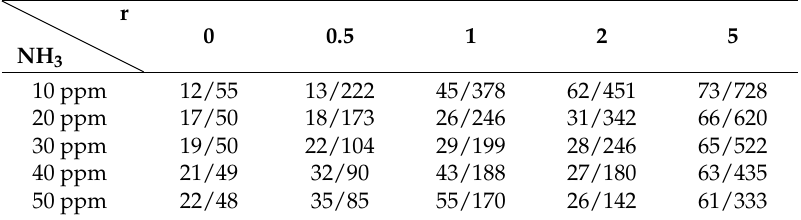
Figure 6. ( a ) Sensor response of the TiO 2 @PANI samples with different m (TiO 2 )/m (Ani) to NH 3 gas ranging from 10 to 50 ppm at room temperature; ( b ) the corresponding sensitivity curve. Table 1. The response/recovery times of the gas sensors to different contents of NH 3 gas, where the r is the mass ratio of TiO 2 and Ani (m (TiO 2 )/m (Ani)).